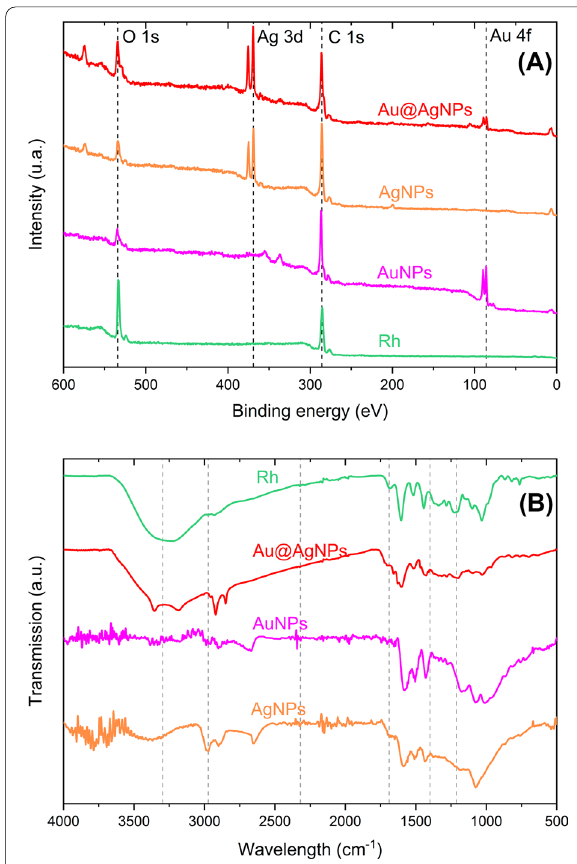
Fig. 2 XPS survey spectra ( a ), and FTIR ( b ) for Rh, Ag, Au, and Au@